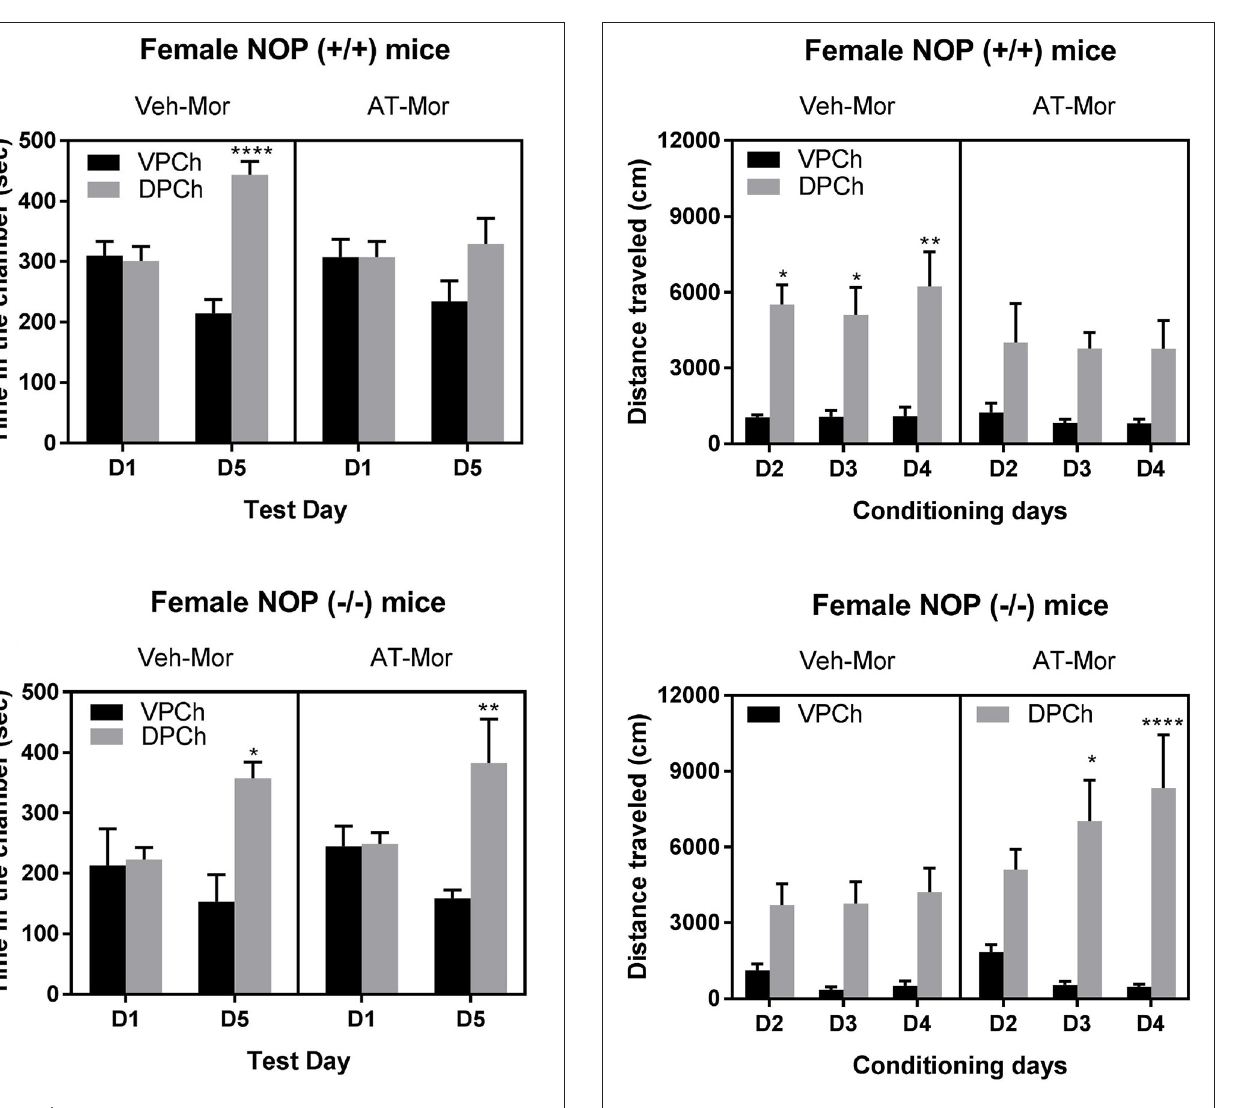
Figure 3 shows the amount of time that wild-type (upper panel) and knockout (lower panel) mice spent in the vehicle- paired chamber (VPCh) and drug-paired chamber (DPCh) on the preconditioning (D1) and postconditioning (D5) test